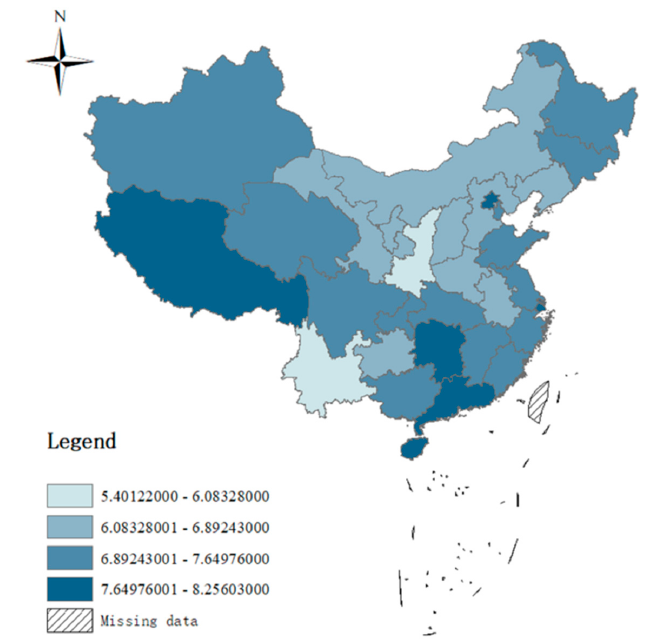
Figure 2. Distribution of food poverty Figure 2 . Distribution of food poverty lines.